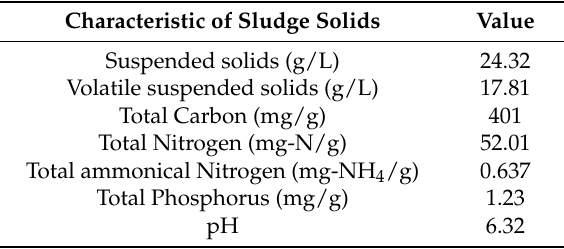
Table 1. Characteristics of raw municipal wastewater